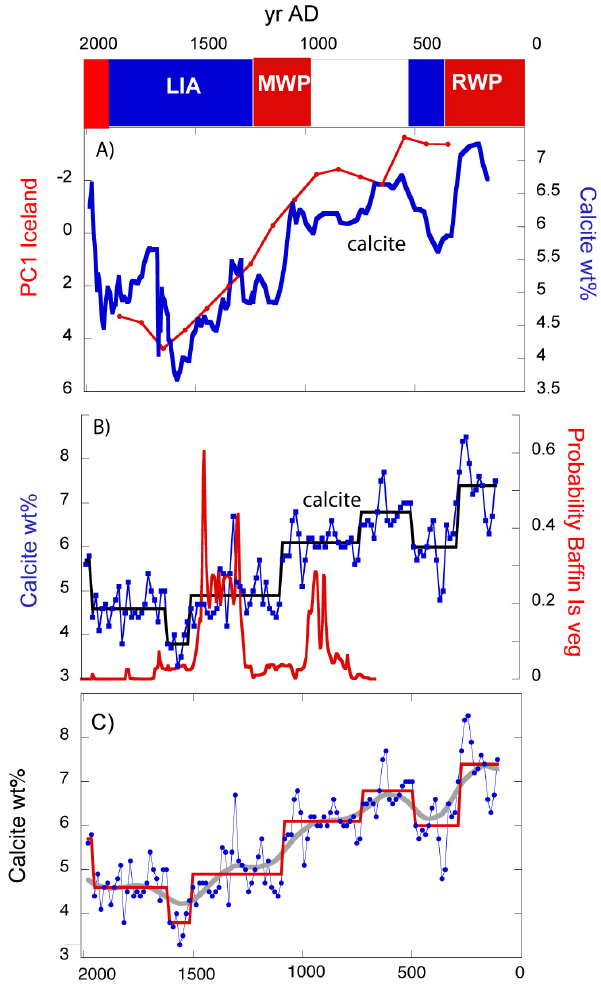
Fig. 8. (A) Climate intervals of the last 2000yr and a graph of the 1st PC scores from the N Iceland proxy data (red) (Axford et al., 2011) versus the smoothed (5-point average) weight% calcite (blue) from the combined HU93030-019B and MD99-2322; (B) 15yr cal- cite wt% (blue) and regime shift mean values versus the radiocar- bon calibrated probability distribution for Baffin Island vegetation (Miller et al., 2012) (red); (C) quartz wt% (grey line with filled cir- cles), regime shifts (black line) and the trend (heavy grey